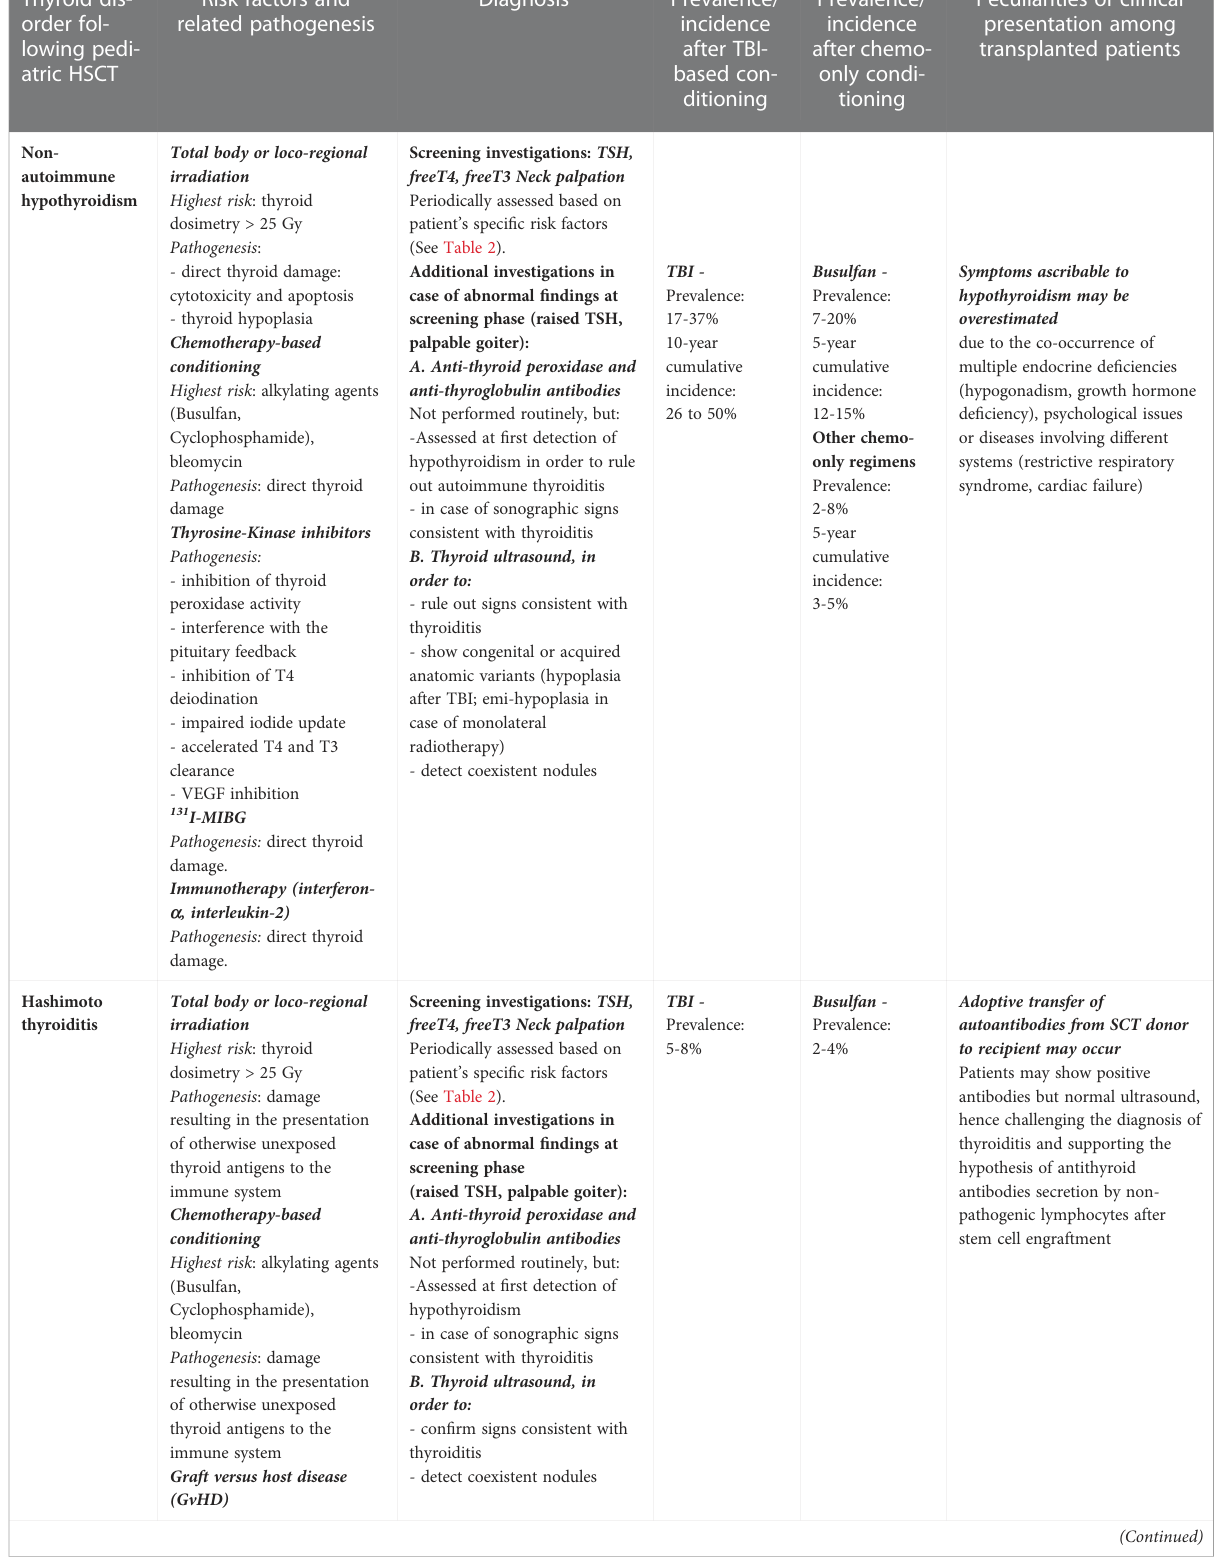
TABLE 1 Thyroid disorders following stem cell transplantation: risk factors, occurrence rates and speci fi cities among HSCT survivors conditioned with TBI-based or TBI-free regimens. Thyroid dis- order fol- lowing pedi- atric HSCT